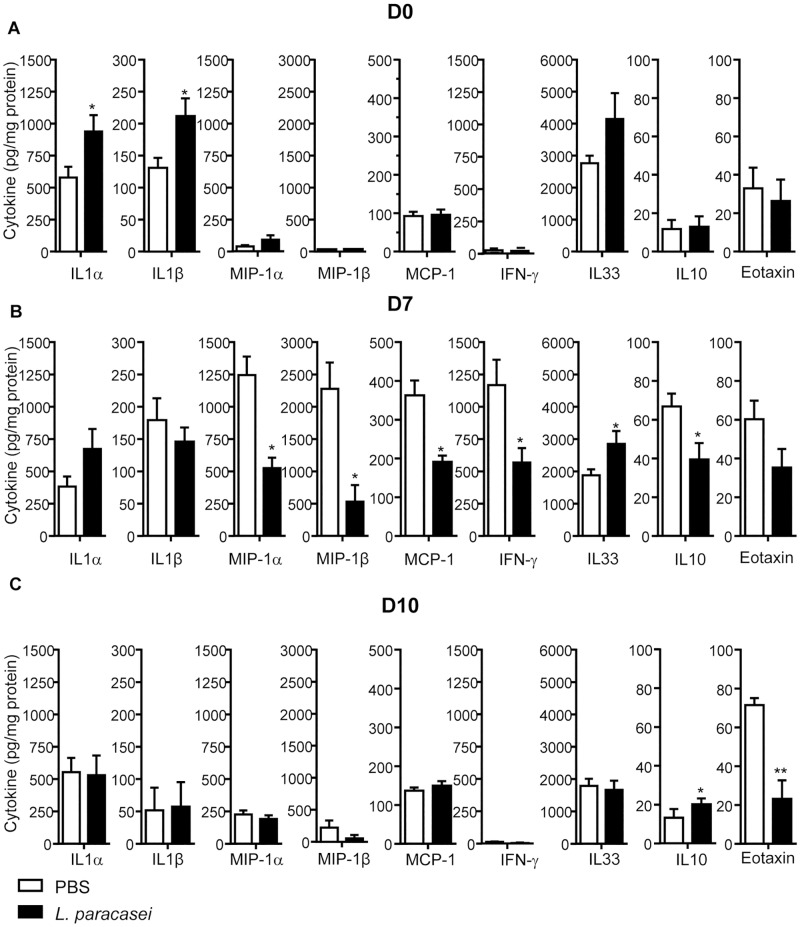
Effects of consumption of L. paracasei on cytokine profiles, compared with the control group.A: day 0, B: day 7, C: day 10 after influenza infection. Results are expressed as mean ± SEM for each group (n = 8).